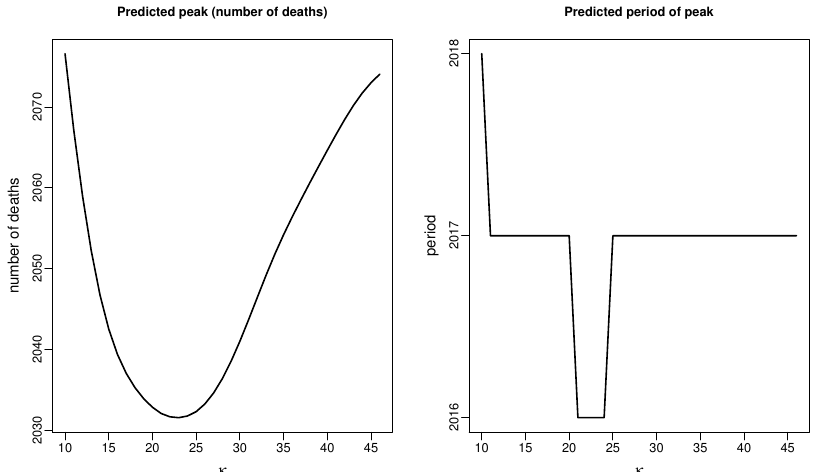
would have been able to predict the peak in 2016. Figure 7 shows the peak forecasts for different values of κ along with the year of peak. Peak values vary with κ between 2032 and 2077 and the year of peaking between 2016 and 2018. The observed peak of 2101 in 2016 is, therefore, hardly predicted using data up to 2013. The same happens with the forecasts derived by [19], which predicted a peak of 2079 deaths in 2017. This seems to be curve, while the actual numbers in years close to the peak are expected to fluctuate above and below due to year-on-year random variation [39].